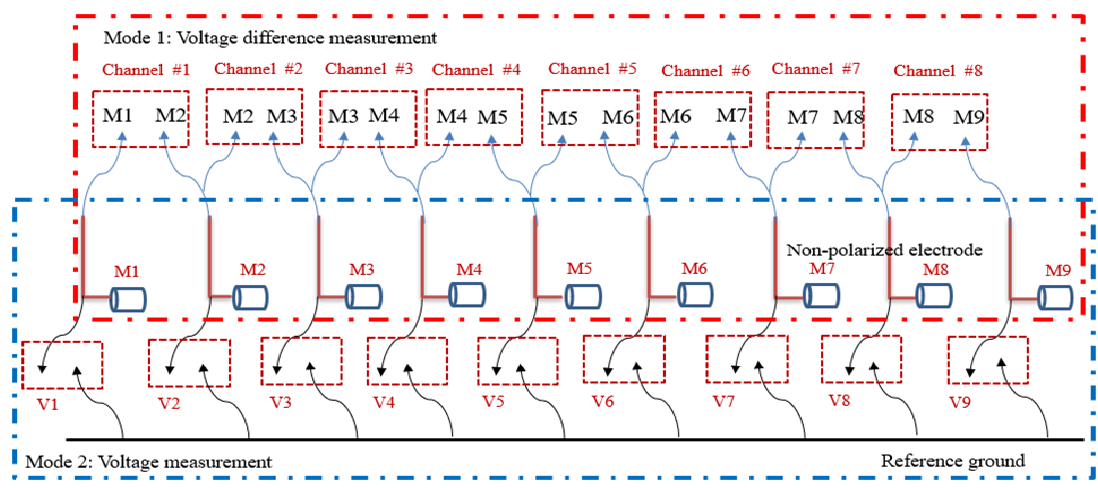
Figure 11. Measurement diagram.